Question: In one sentence, what is this figure communicating?
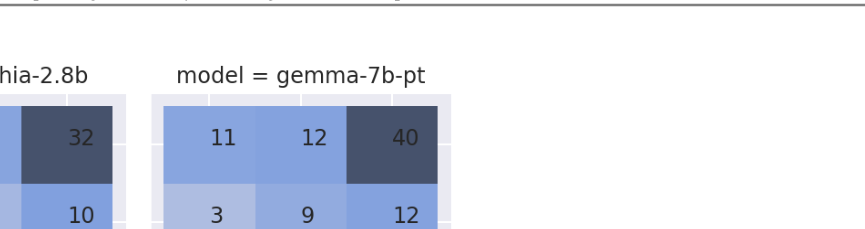
Answer: | Contingency table showing Gated vs Baseline interpretability labels from our paired study results, for Pythia-2.8B and Gemma-7B.